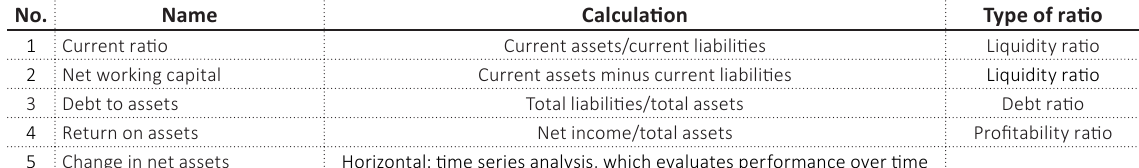
Table 1. Ratios employed in the